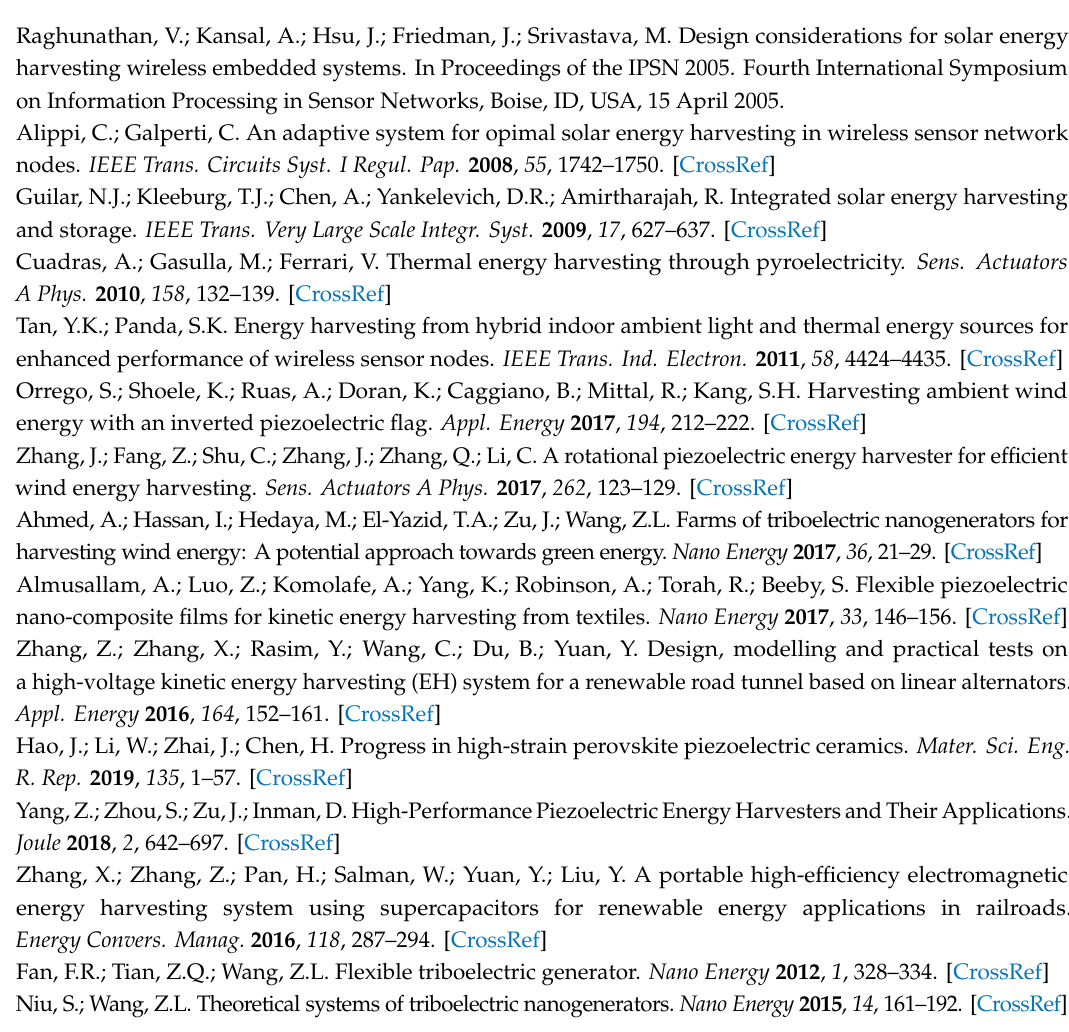
Figure S1: The actual optical images of WAO-Al and DE-Al electrodes, Figure S2: The SEM image of DE-TENG (for 60 min of sputtering time), and Figure S3: The endurance test of DE-TENG for the period of 5